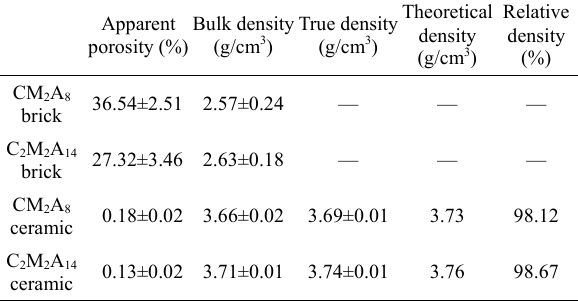
true density of CM 2 A 8 and C 2 M 2 A 14 bricks and